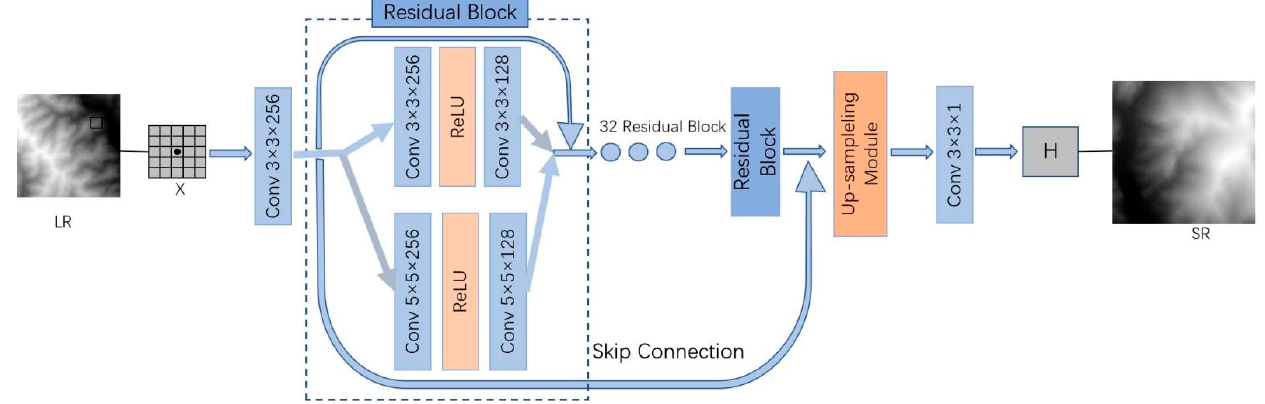
Figure 2. An enhanced double-filter residual neural network (EDEM-SR) to generate SR DEMs. The residual block has a double-filter of different kernel size as detailed in Figure 3; Conv denotes convolutional layers.